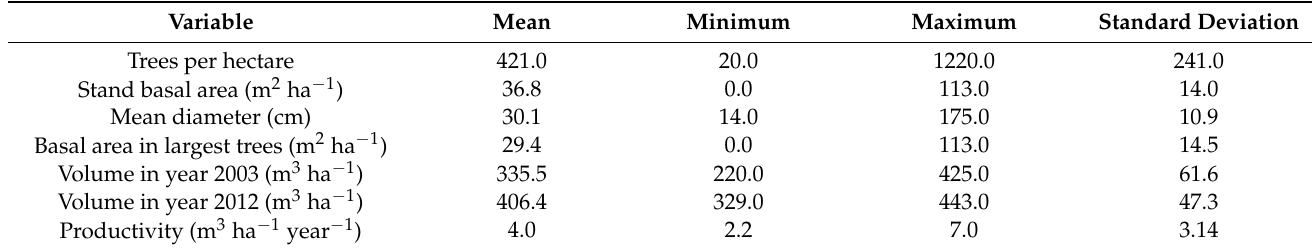
Table 1. Characteristics of the study area based on permanent forest monitoring plots in typical uneven-aged and mixed forests in northern Iran.